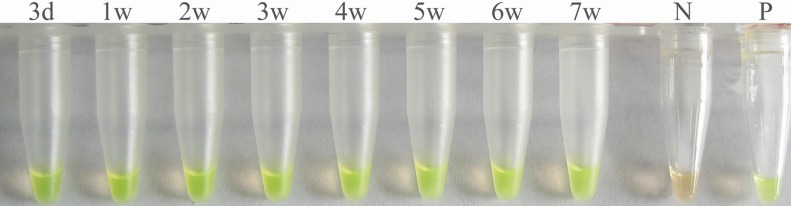
Detection of Schistosoma japonicum DNA in sera of rabbits with light-infection by LAMP.Serum samples were collected at 3 days (3d) and 1–7 weeks (1w–7w) post-infection. Tube N, serum of non-infected rabbits; tube P, DNA of S. japonicum adult worm (positive control).